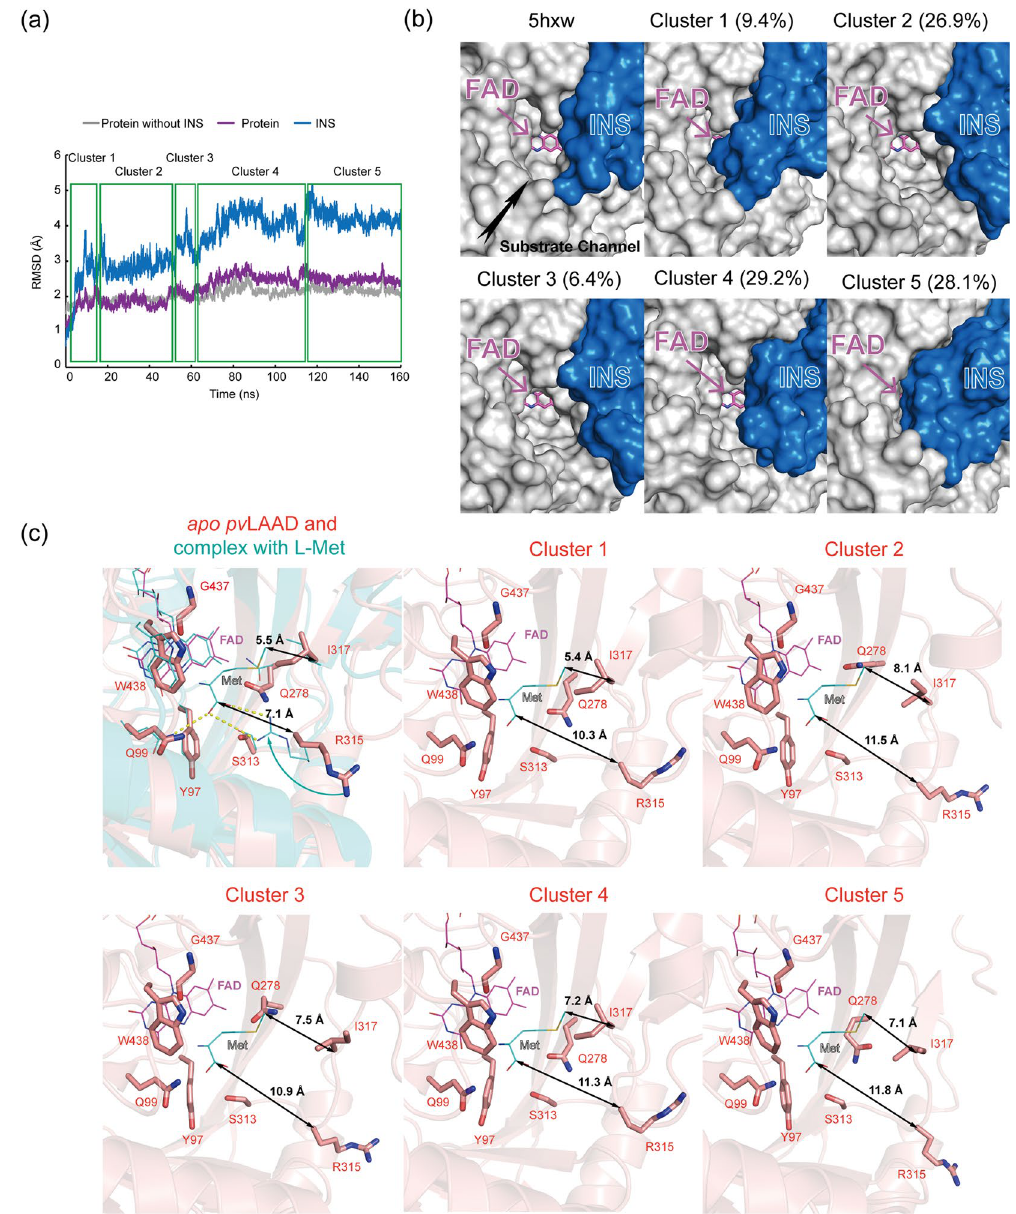
Figure 3. Molecular dynamics simulations of pv LAAD. 160 ns of MD simulation was performed with AMBER12 program package using the crystal structure of Δ N- pv LAAD (PDB code 5hxw) as the start model. ( a ) The RMSD-based trajectory analysis showed that the overall structure of Δ N- pv LAAD (purple) was stable, but the INS was flexible. The conformations of the INS were clustered to five classes. ( b ) The representative structures of each cluster. The INS was colored blue and the rest part of pv LAAD was colored white. The INS showed large movement among different clusters. The substrate channel opened in cluster 2 (26.9% population) and cluster 3 (6.4% population), but tended to close in cluster 1, 4 and 5. ( c ) The catalytic pockets of the representative structures of each cluster. While key residues Y97, Q99, Q278, S313, G437 and W438 were stable during MD simulations, residue R315, which could interact with the carboxyl group of amino acid substrates, and residue I317, which could contact with the side chain of the substrate amino acids, deviate from their initial positions in catalytic site during MD simulations. The apo pv LAAD structure (PDB code 5hxw) was colored orange, and its complex with L-methionine was modeled 24 and colored